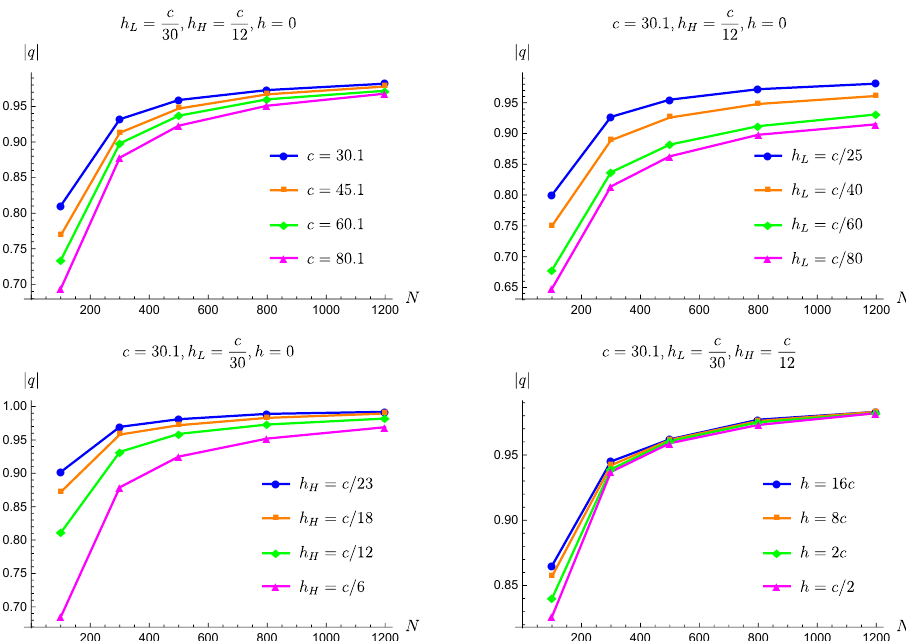
q where the q -expansion converges for various choices j j